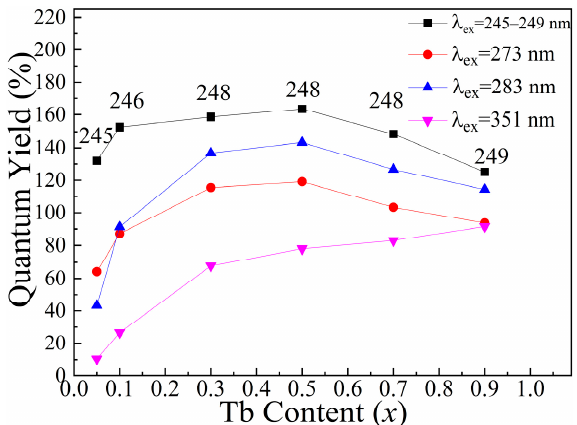
Figure 6. Quantum Yields of KGdC: x Tb 3+ under different excitation